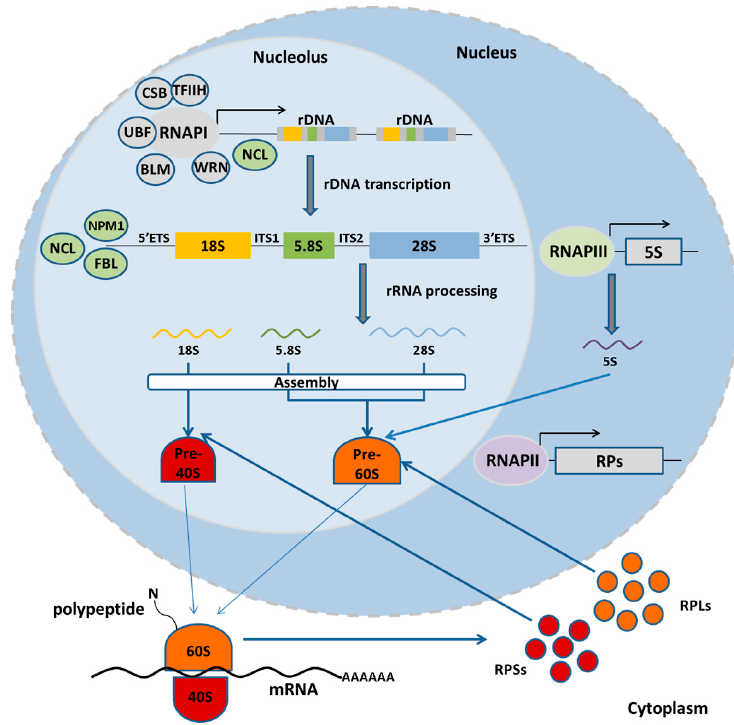
Figure 1. The function of nucleolus. In normal state, the RNA Pol I machinery transcribes a polycistronic pre-rRNA molecule, which is subsequently processed to mature rRNAs (18S, 5.8S, and 28S) of the small and large ribosomal subunit. Outside the nucleolus, RNA Pol III transcribes the fourth rRNA (5S), while RNA Pol II transcribes the ribosomal protein genes to be translated in the cytoplasm. Ribosomal proteins of the large (RPLs) and the small (RPSs) subunit enter the nucleolus to associate with rRNAs and assemble the ribosomal subunits, which are then exported to the cytoplasm.